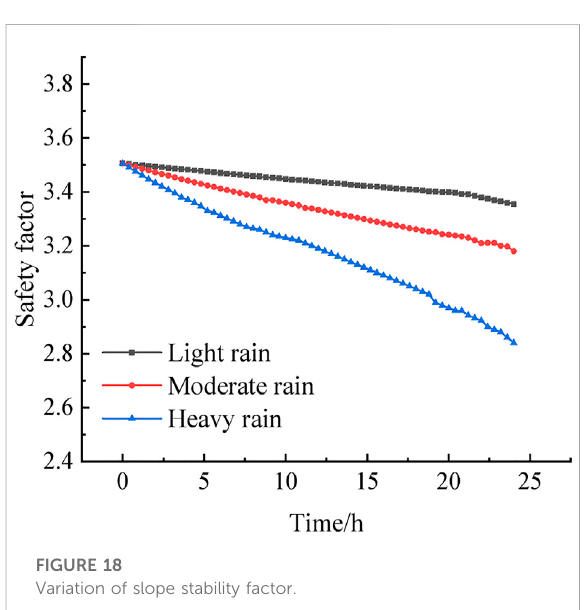
FIGURE 18 Variation of slope stability factor.